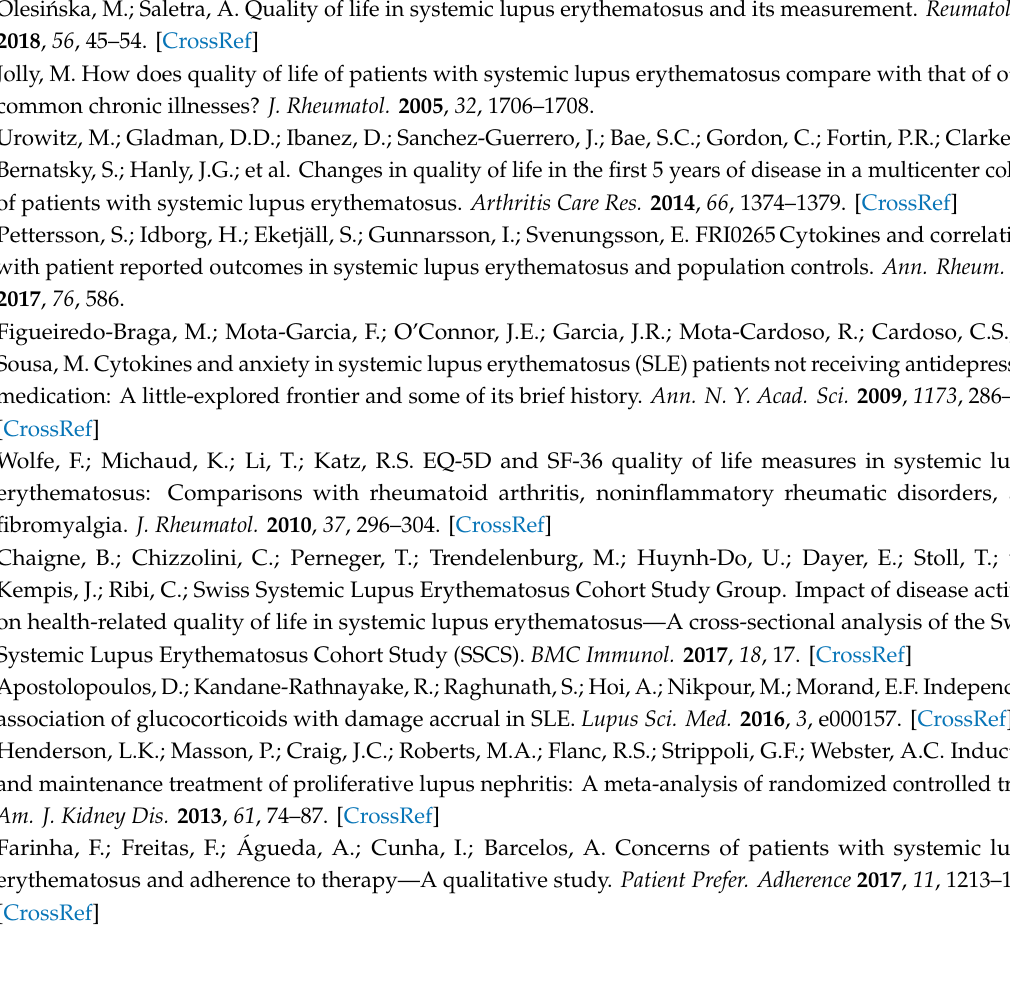
Table S1: Spearman rank correlation coe ffi cients (Rs) for relation between SF36 domain and summary scores with clinical findings and disease activity and presence of organ